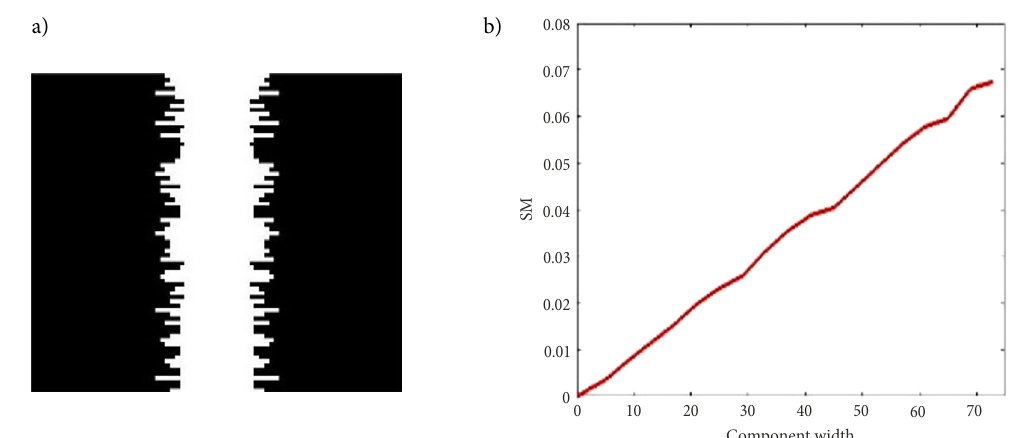
Figure 11. Relation between crack width and SM: a – 25-pixel wide crack; b – relation